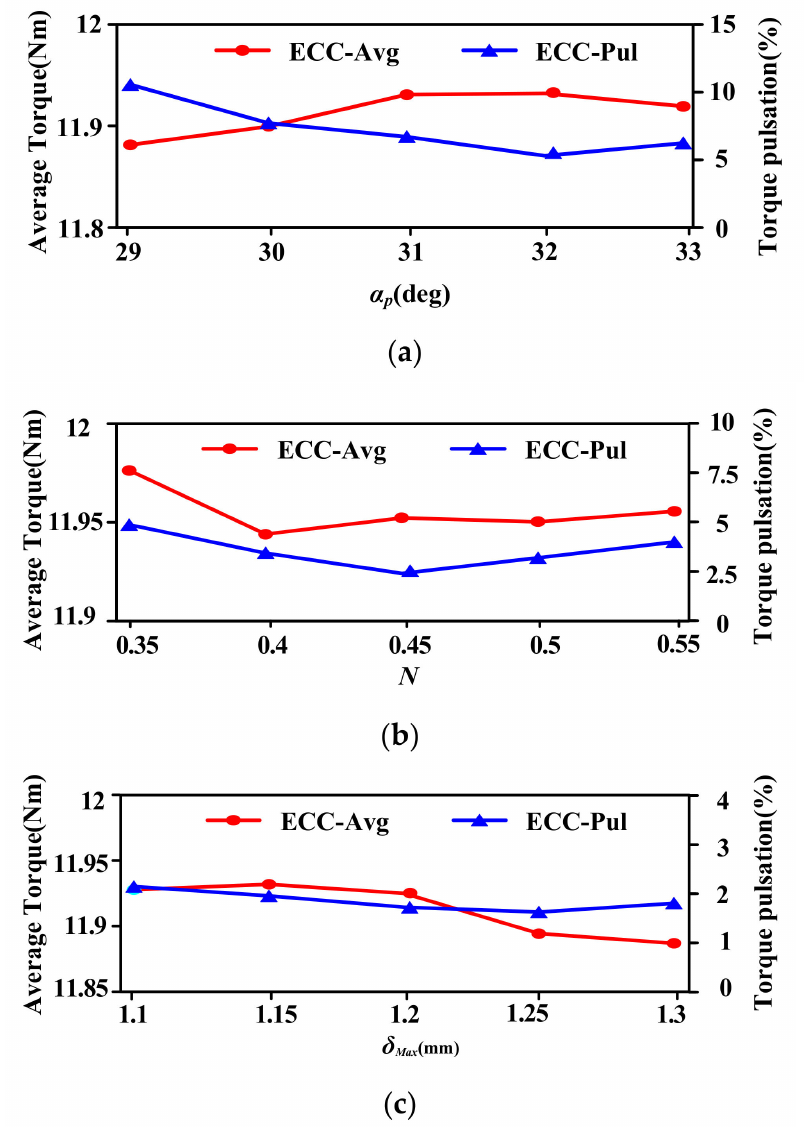
Figure 6. Average torque and torque pulsation of ECC ASP vary with ( a ) α p . ( b ) N . ( c ) δ max . Figure 7 shows the two models differ only in the α p . It can be seen ECC ASP obtains higher average torque and lower torque pulsation. According to Section 3.2, l avg is inversely proportional to the average torque. The calculating results are shown in Table 3. The l avg of traditional ECC is larger than the ECC ASP. Therefore, the FEM results are consistent with the theoretical